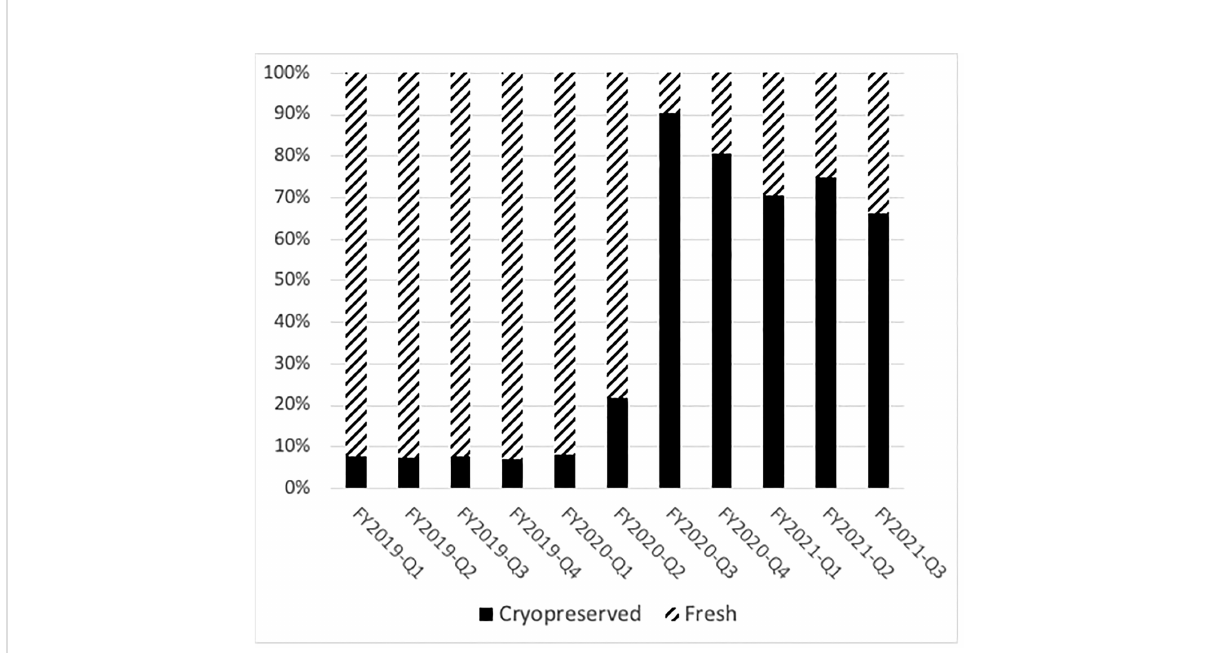
FIGURE 1 Cryopreservation rates of domestic donor PBSC and marrow collections drastically changed during the pandemic. The percentage of fresh products per quarter is shown in hatched bars, and the number of cryopreserved products is shown in black bars.